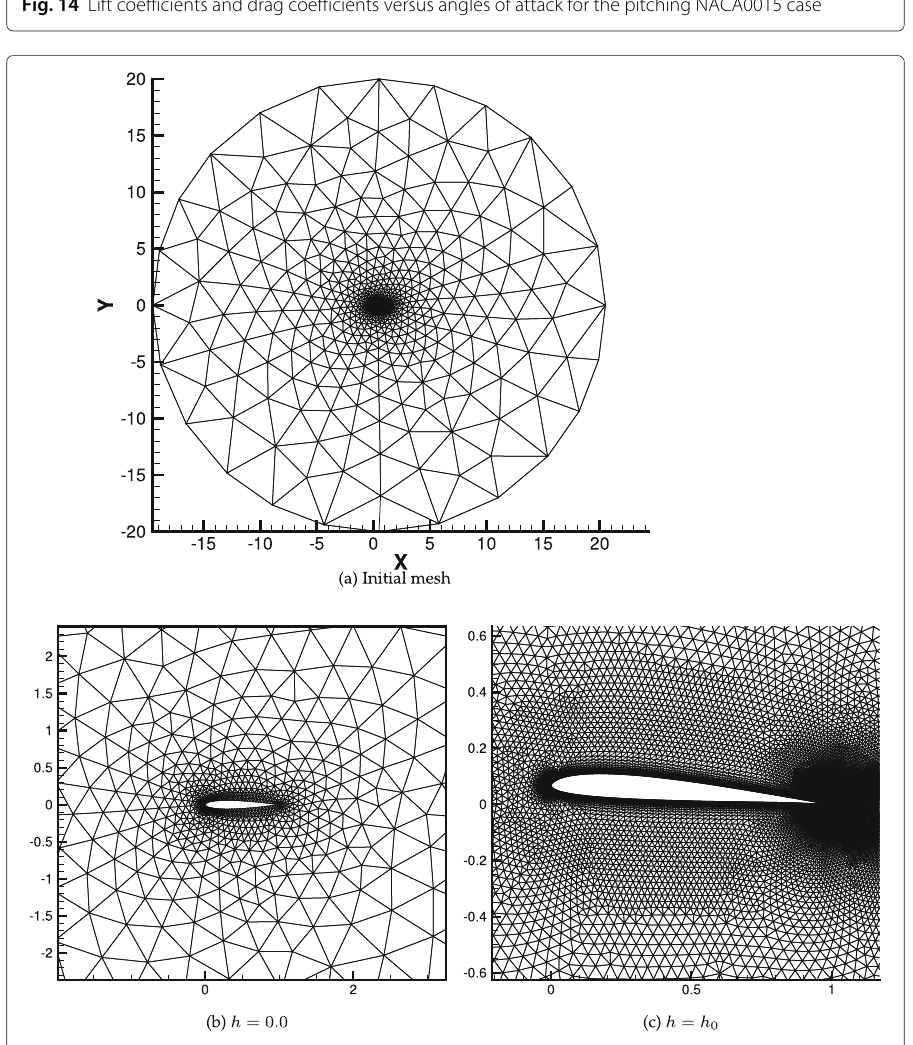
Fig. 15 Zoomed-in mesh near the airfoil of the plunging SD7003 case. left: initial mesh; right: mesh at maximum angle of